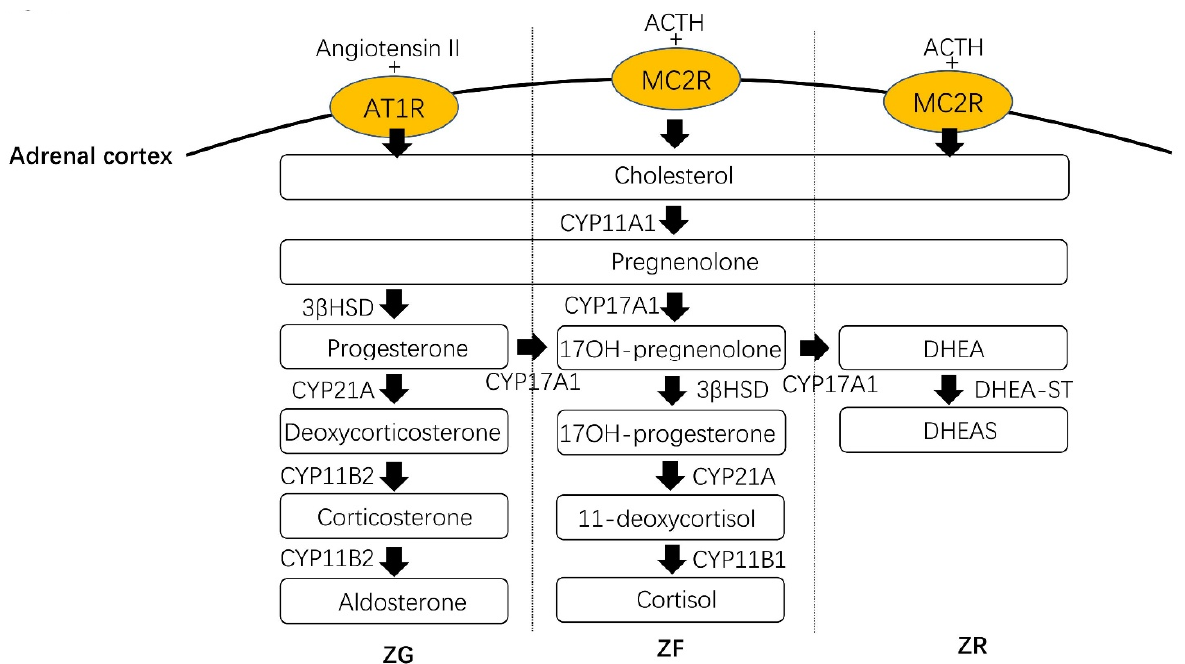
Figure 2. The pathway of steroids biosynthesis. The adrenal cortex receives many singling proteins by binding their receptors to stimulate steroid biosynthesis. Two key stimulators are angiotensin II (ANGII) and adrenocorticotropic hormone (ACTH) which are regulated by the renin-angiotensin-aldosterone system (RAAS) and hypothalamic-pituitary-adrenal (HPA) axis, respectively. ANGII binds to angiotensin II type 1 receptor (AT1R) to initiate aldosterone biosynthesis in ZG. Whereas ACTH binds to melanocortin receptor 2 (MC2R) resulting in the activation of cortisol and adrenal androgen biosynthesis in ZF and ZR, respectively. Cholesterol is the precursor of aldosterone, cortisol and adrenal androgen and is firstly converted to pregnenolone catalyzed by cytochrome P450 side-chain cleavage (CYP11A1) from the cytoplasm to the outer mitochondrial membrane [52–54]. Pregnenolone is then catalyzed into progesterone under the activation of 3 β -hydroxysteroid dehydrogenase (3 β -HSD) [52,53]. 21-hydroxylase (CYP21A2) then catalyze progesterone into deoxycorticosterone [55] and aldosterone synthase (CYP11B2) finally catalyzes it into aldosterone [52,53]. On the other hand, cortisol is produced in the zona fasciculata (ZF). Then, 17-alpha-hydroxylase/17,20 lyase (CYP17A1) can catalyze pregnenolone and progesterone into 17-alpha-pregnenolone and 17-alpha-progesterone, respectively. Then, 17-alpha-progesterone is converted into 11-deoxycortisol, catalyzed by CYP21A2, and finally to cortisol, catalyzed by 11 β -hydroxylase (CYP11B1) [52–54]. Cortisol is finally biosynthesized under the activation of (CYP11B1) [52,53]. CYP17A1 can also catalyze 17-alpha-pregnenolone and 17-alpha-progesterone into dehydroepiandrosterone and androstenedione, respectively in ZR. Then they are biosynthesized to androgen by 17 β -hydroxysteroid dehydrogenase type 5 (17 β -HSD5) in periphery tissues [56].